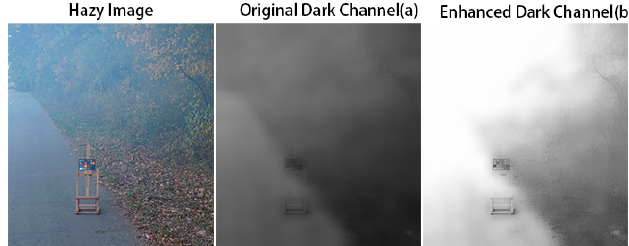
Figure 2. The original dark-channel map ( a ), and the dark-channel map after training and Figure2. Theoriginaldark-channelmap( a ),andthedark-channelmapaftertrainingandenhancement( b enhancement ( b ).